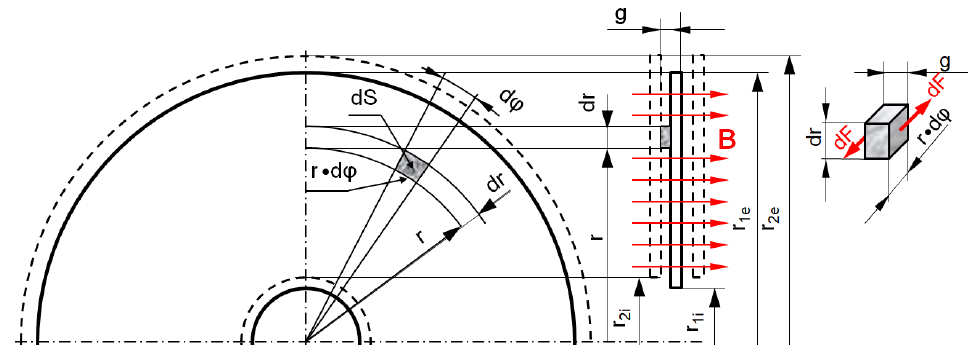
Figure 6. Geometrical denotations for calculating clutching torque acting on a single disc surface.